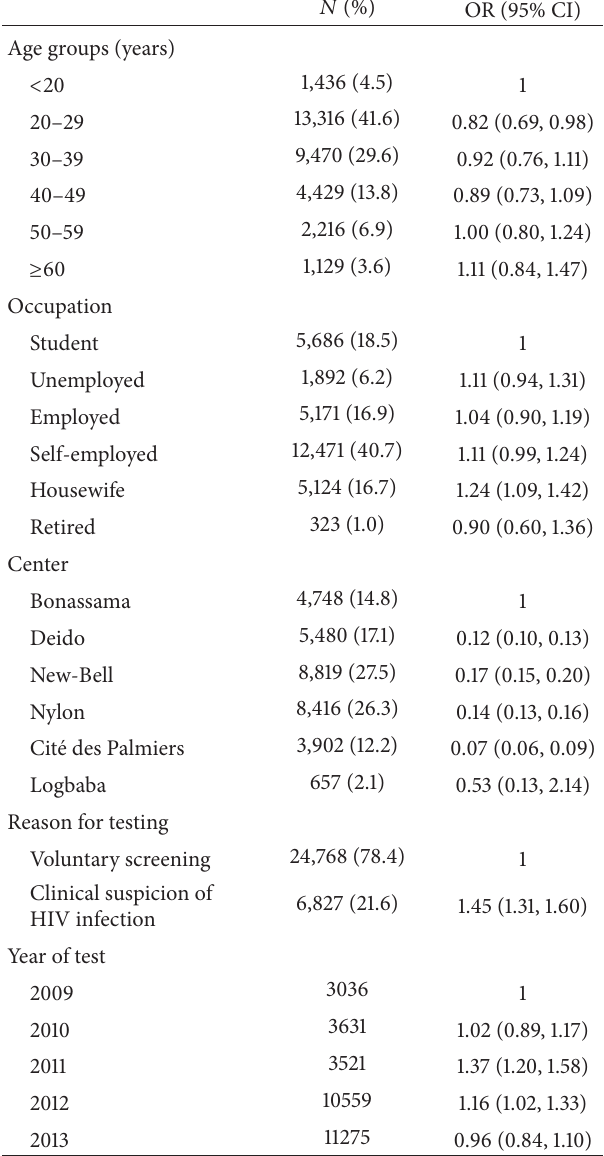
Table 3: Predictors of failure to return for HIV test